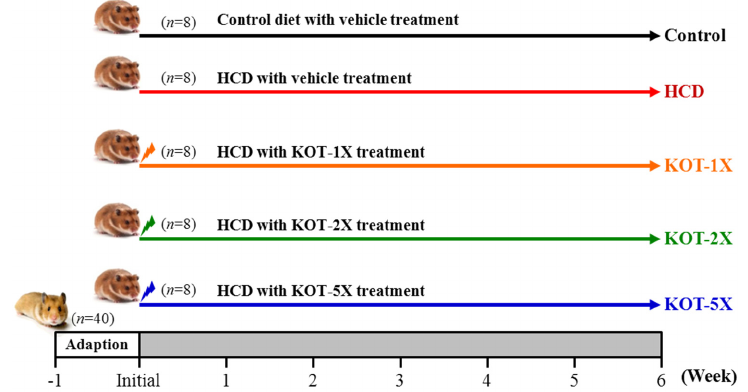
Figure 1. Experimental design for hamsters. Control: standard laboratory diet and the same volume of solution equivalent to body weight (BW). HCD (high ‐ cholesterol diet), HCD and the same volume of solution equivalent to BW; KOT ‐ 1X, HCD and 2787 mg/kg/day KOT; KOT ‐ 2X, HCD and 5573 mg/kg/day KOT; KOT ‐ 5X, HCD and 13,934 mg/kg/day KOT. KOT: tomato juice from Kagome Ltd.